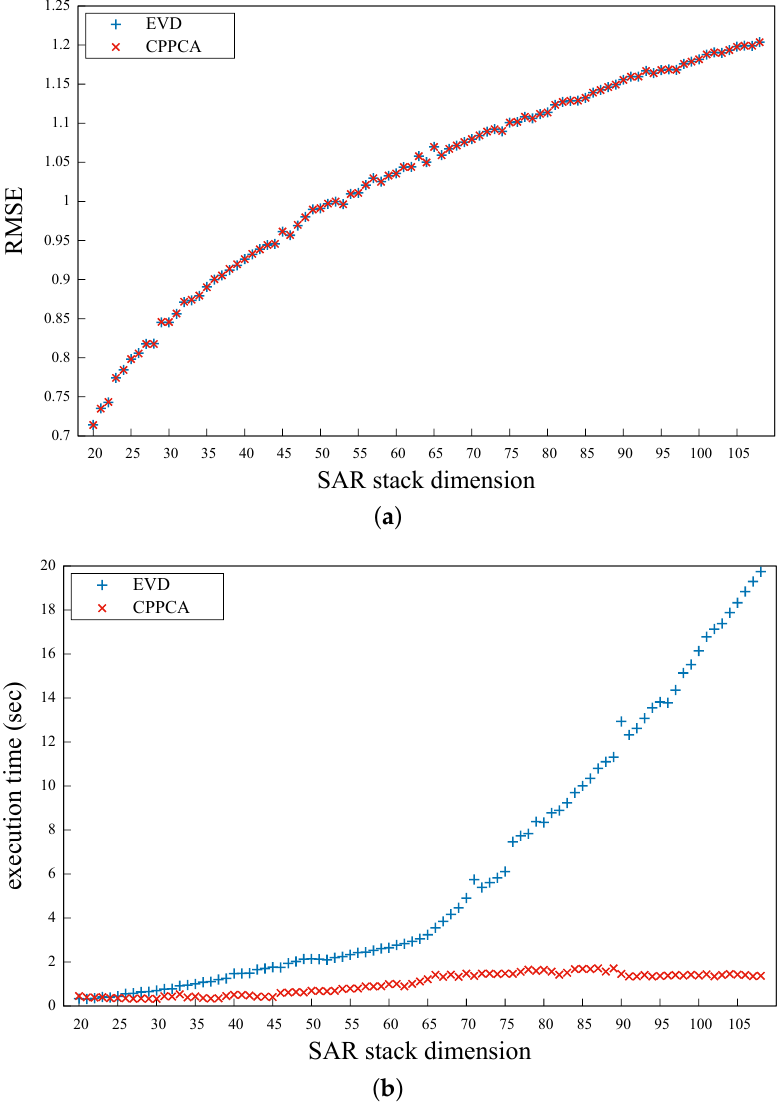
Figure 2. The RMSEs ( a ) and the execution times ( b ) under different SAR stack